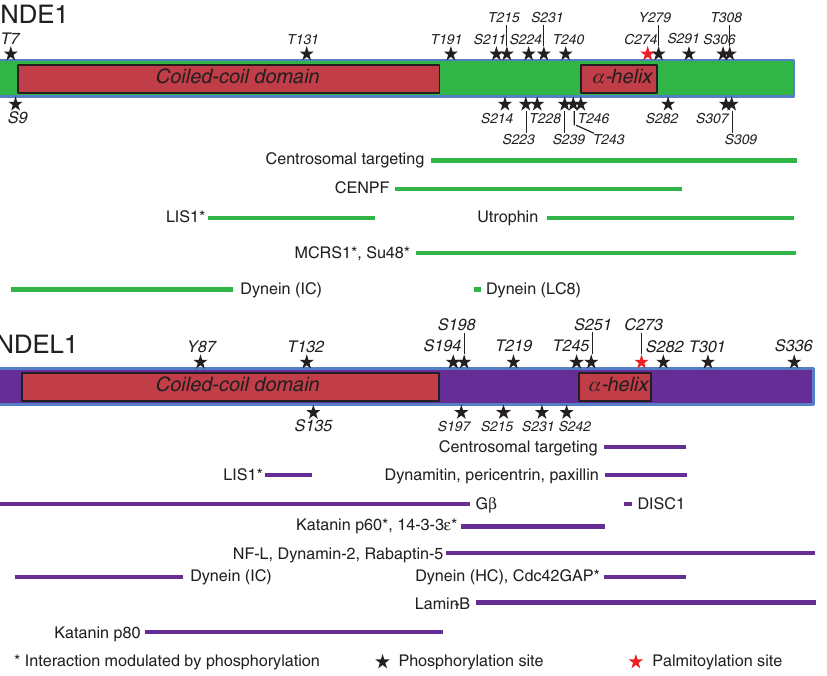
Figure 4 Domain architecture, post-translation modification and binding/functional regions of NDE1 and NDEL1. Schematics of NDE1 (top panel) and NDEL1 (bottom panel) drawn to scale depicting the N-terminal coiled-coil domain and the predicted C-terminal α -helix (labeled); the central flexible linker region connects these two structured regions, while another unstructured region lies at the extreme C-terminus of the proteins. Numerous PTMs (stars) reside within delineated protein-protein interaction sites, sub-cellular localization regions, or oligomerization domains with the vast majority located within predicted unstructured regions of the proteins. Minimal essential protein-binding sites from the literature are shown drawn to scale (NDE1: green bars; NDEL1: purple bars). References for each NDE1 interaction site are as follows: Centrosomal targeting (98); Centromere protein F (CENPF)/Mitosin/LEK1 (112); LIS1 (4); Utrophin (66); MCRS1/p78 (99); Su48/ DBZ/ZNF365 (98); Dynein IC (89); Dynein (LC8) (49). References for each NDEL1 interaction site are as follows: Centrosomal targeting (113); LIS1 (96); Dynamitin (50); Pericentrin/Kendrin (113); Paxillin (114); G-protein β (G β ) (115); DISC1 (28); Katanin p60 and p80 (68); 14-3-3 ε (100); Neurofilament (NF)-L (72); Dynamin-2 (75); Rabaptin-5 (78); Dynein intermediate chain (IC) (89); Dynein heavy chain (HC) (1); Cdc42GAP (74); Lamin-B (63). Note: the palmitoylation site C273 (red star) on NDEL1 is also the site of endooligopepti- dase activity (77). In the majority of cases, these sites have only been investigated for one of NDE1 or NDEL1; it is likely that some of them will be conserved between the two proteins. The effect of PTMs should be tested on protein conformation, stability, oligomerization, modu- lation of protein-protein interaction and cellular